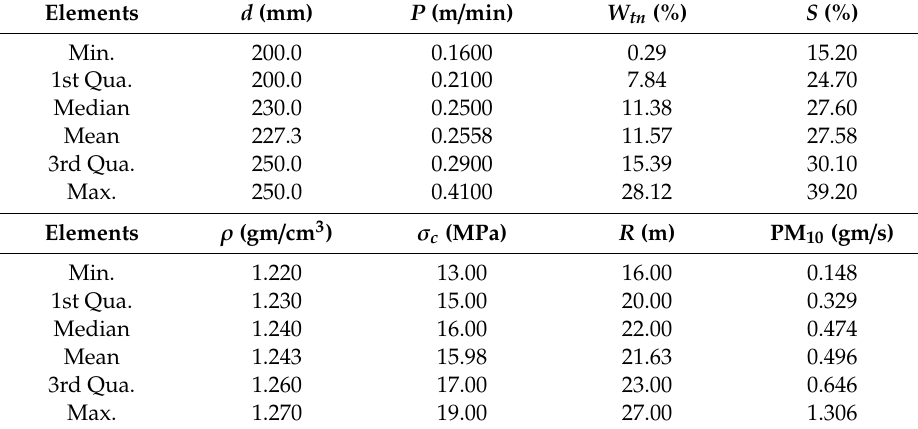
Table 2. Characteristics of the data